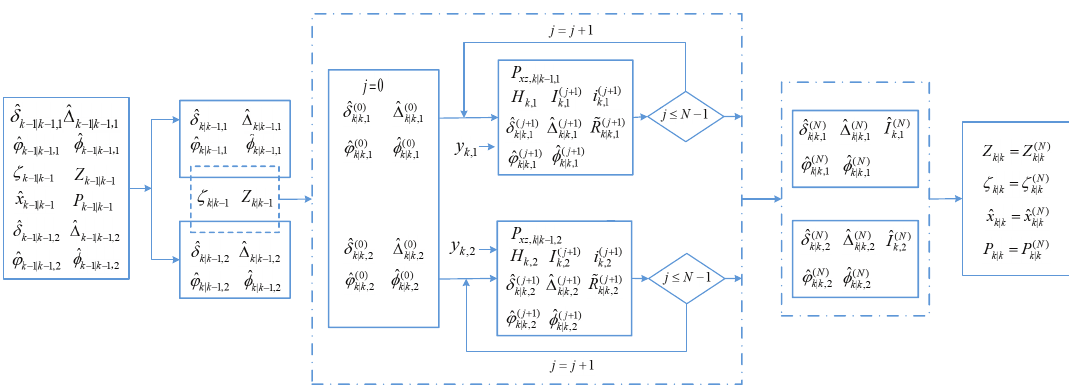
Figure 2. Flow-chart of proposed VBST-CIFF (variational Bayesian Student’s t-based-cubature information feedback